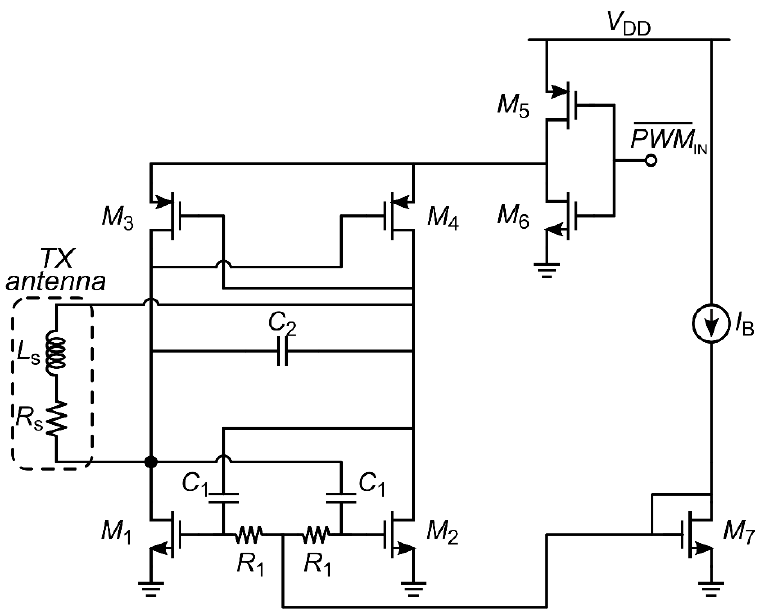
Figure 14. Simplified schematic of the RF oscillator of the TX front-end.